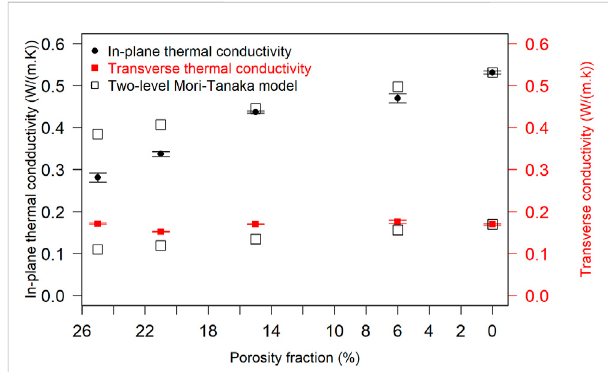
FIGURE 14 Comparison of measured values of the thermal conductivity